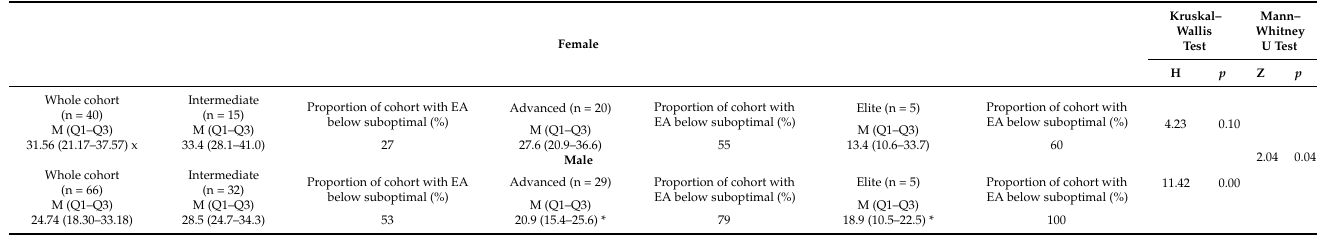
Table 2. Comparison of energy availability (kcal/kg FFM/day) between different climbing levels in the male and female groups and between sexes, and the proportion of each cohort (%) with low EA (<30